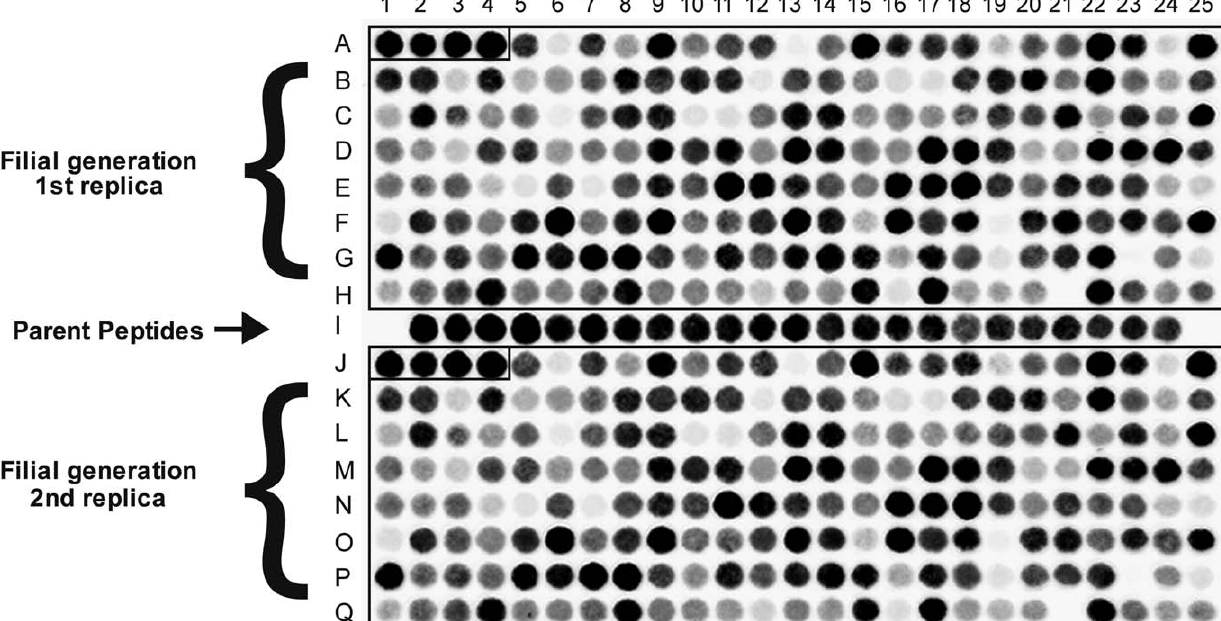
Figure 1. Biochemical assay to determine candidate peptide fitness. SPOT Libraries of peptides were synthesized on cellulose membrane supports and screened for ganglioside binding with fluorophore-labeled lysoG M1 . Rows A–H and J–Q contain two arrays of the same filial generation of 200 candidate peptides, row I contains the parent peptides used for the creation of this generation, providing an internal reference for the improvement of fitness. The four best lead peptides are again included in each array of the filial generation (spots A1–A4 and